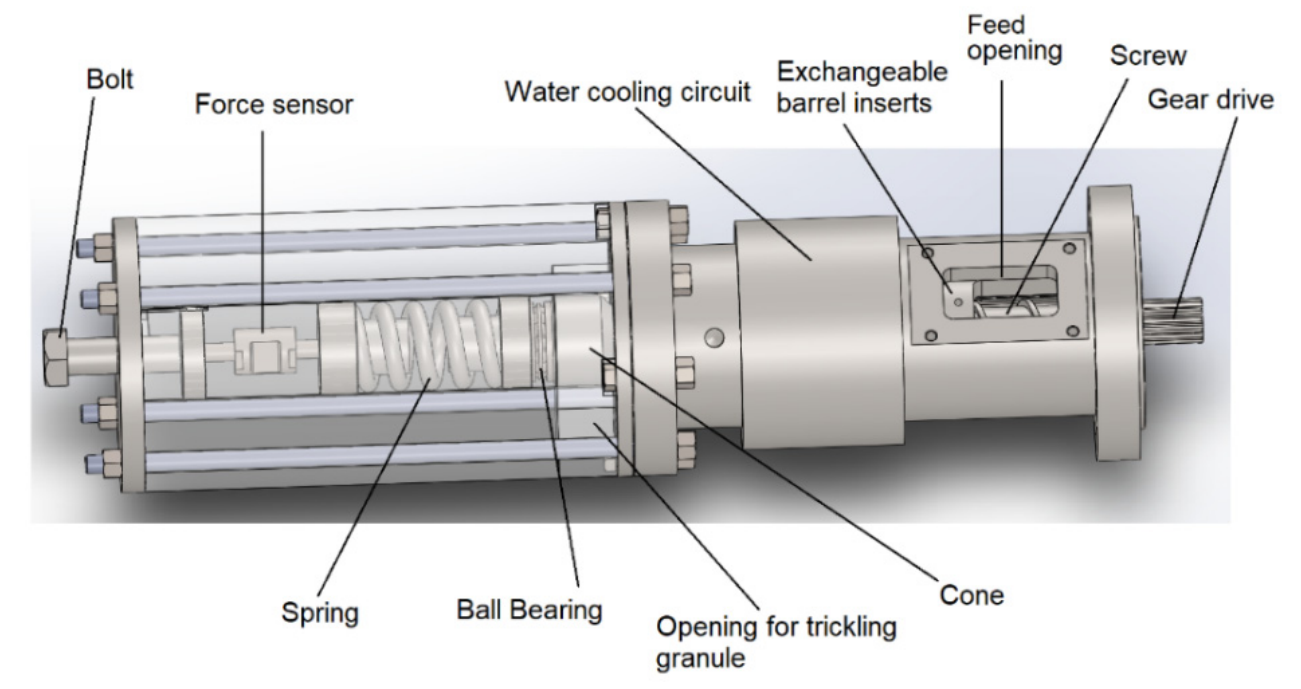
Figure 2. Computer-aided design (CAD) model of the experimental extrusion set-up (mere solid conveying zone) with the mounted back pressure element on the left-hand side.